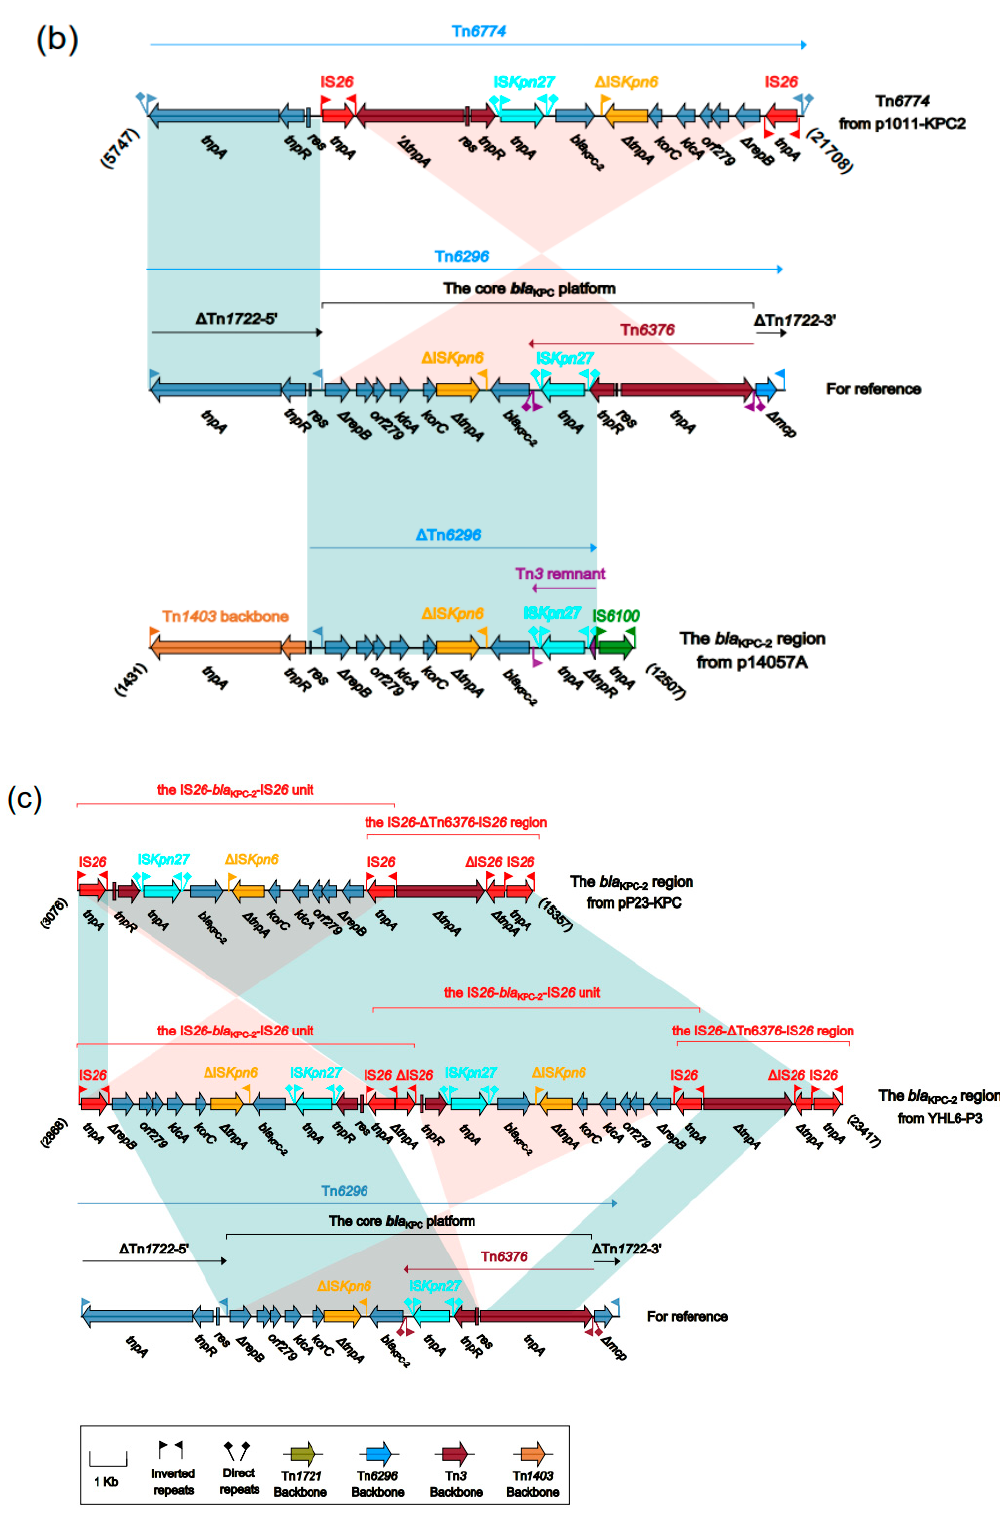
Figure 2. ( a ) The accessory regions pR31-KPC, and comparison with Tn 6296 and Tn 1721 ; ( b ) The accessory regions p1011- KPC2 and p14057A, and comparison with Tn 6296 ; ( c ) The accessory regions of pP23-KPC and YLH6_P3, and comparison with Tn 6296 . Genes are denoted by arrows. Genes, mobile elements, and other features are colored based on function classification. Shading denotes regions of homology (>95% nucleotide identity). Numbers in brackets indicate the nucleotide positions within the corresponding plasmids. The GenBank accession numbers of Tn 1721 , Tn 3 , Tn 6296 , and Tn 1403 are X61367, HM749966, FJ628167, and AF313472,